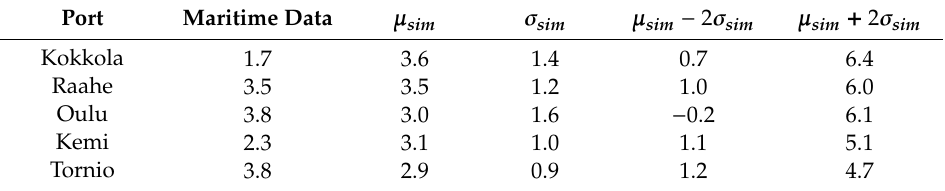
Table 5. Approximated 95% confidence interval for the simulated port-specific mean IB waiting times